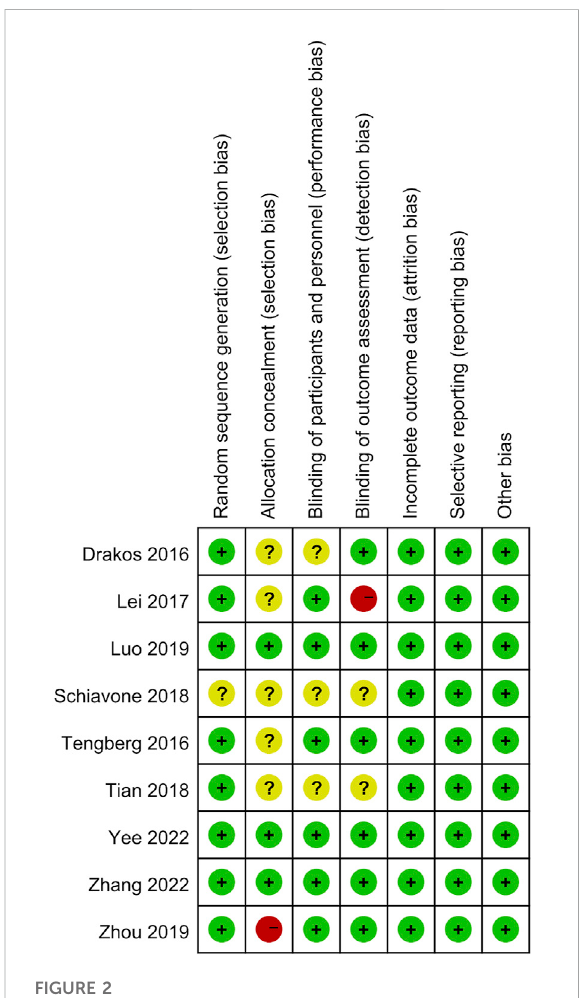
FIGURE 2 Risk of bias summary: low risk of bias in green; unclear risk of bias in yellow; high risk of bias in